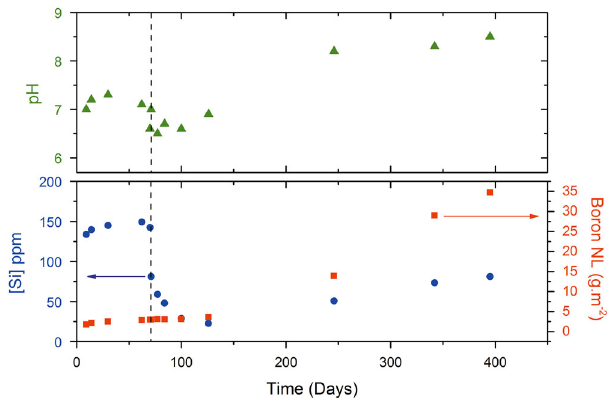
Fig. 1 Upper graph shows the pH ( green triangles ) during the experiment. For each time point, the pH was measured and then adjusted back to 7, except for the last three time points. Lower graph shows the change in Si concentration ( blue circles , bottom left axis ) and the NL ( red squares , bottom right axis ) calculated from the boron concentration in solution. Resumption of alteration is seen